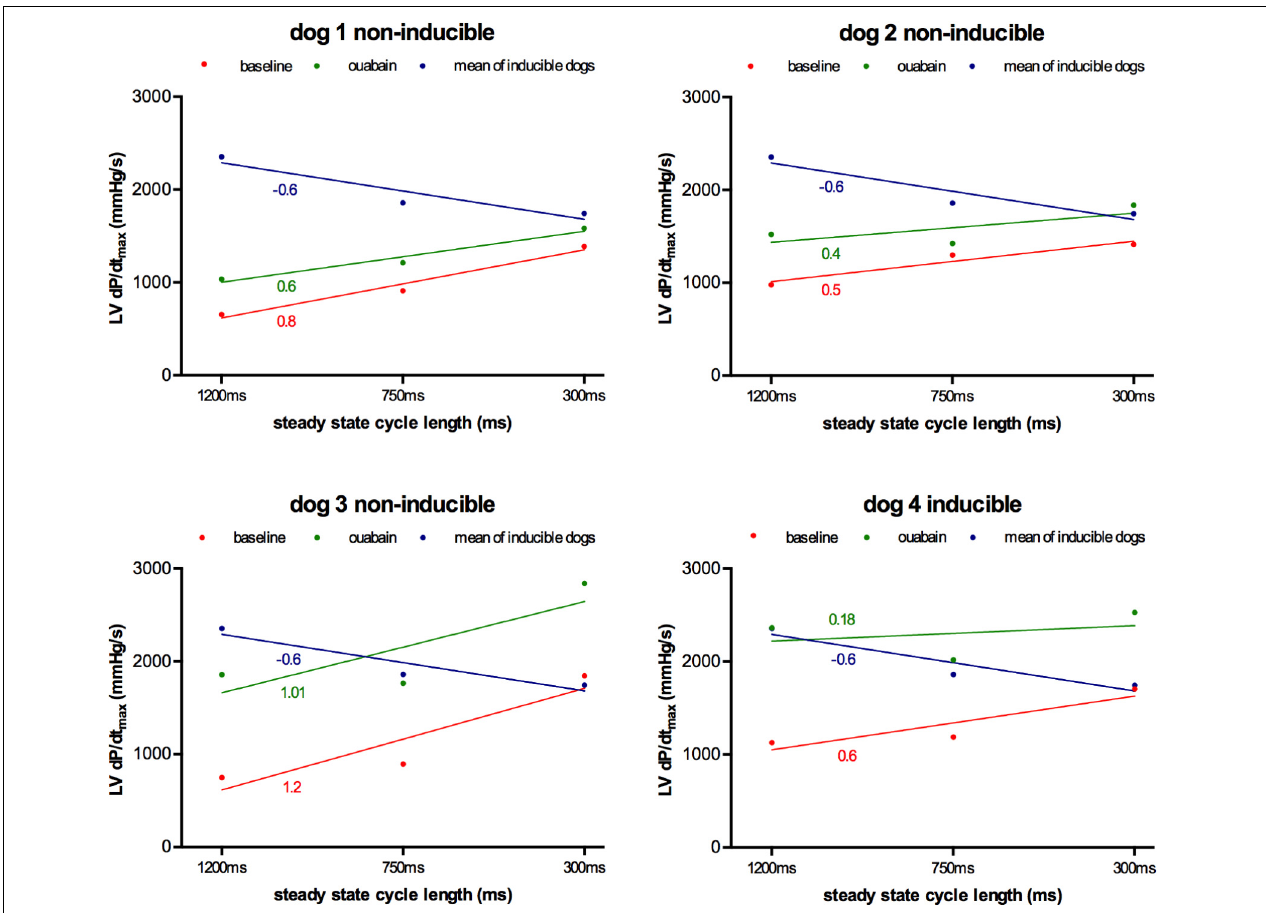
FIGURE 6 | Effect of ouabain on force-frequency relationship in non-inducible subjects ( n = 4). Contractility at CL of 1200, 750, and 300 ms at baseline (red line) and after ouabain (green line) in four non-inducible dogs. As comparison, the mean of the inducible dogs is shown (blue line). Only dog 4 became inducible after ouabain in combination with dofetilide. TCs of the different curves are